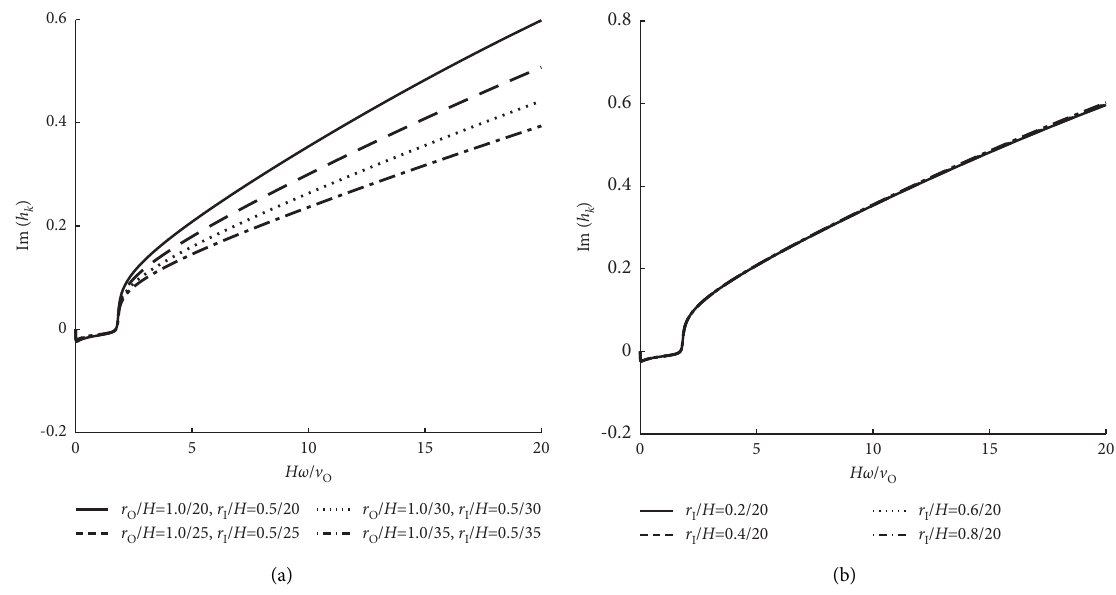
Figure 9: The impedance factor curves of soil layers under different inner radii of pipe pile. (a) Horizontal stiffness factor of the soil layer. (b) Horizontal damping factor of the soil layer.